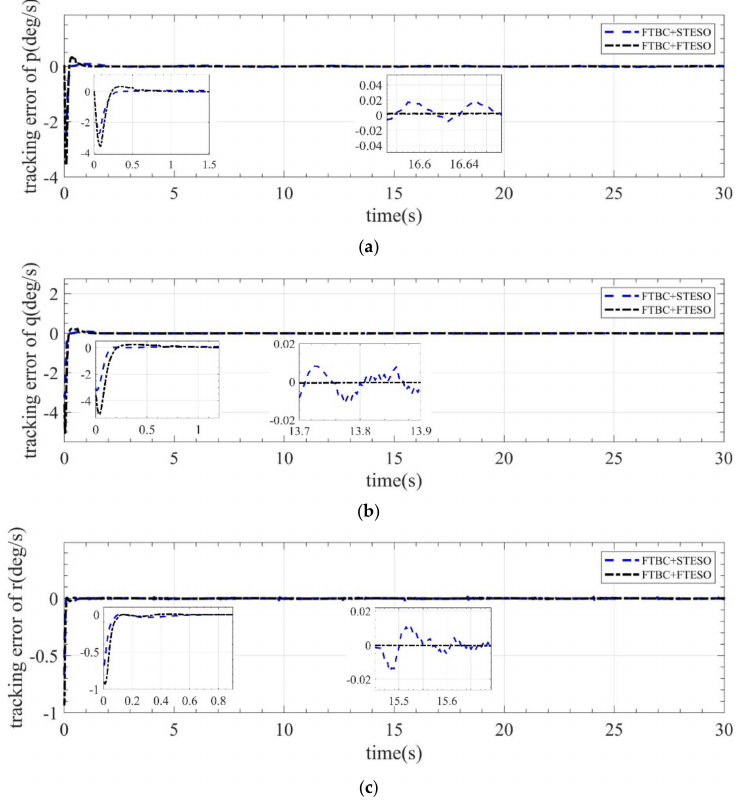
Figure 7. ( a ) Tracking error curve of e p , ( b ) tracking error curve of e q , and ( c ) tracking error curve of e r